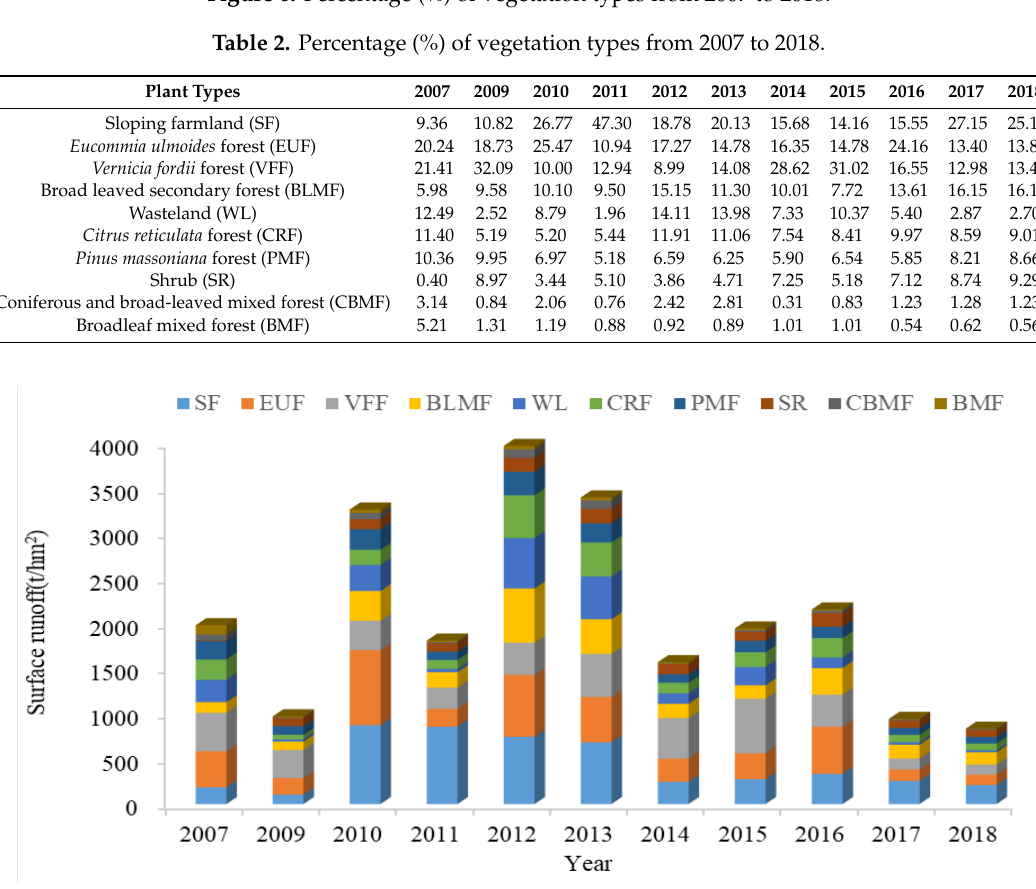
Figure 7. Contribution to runoff generation due to different vegetation covers.